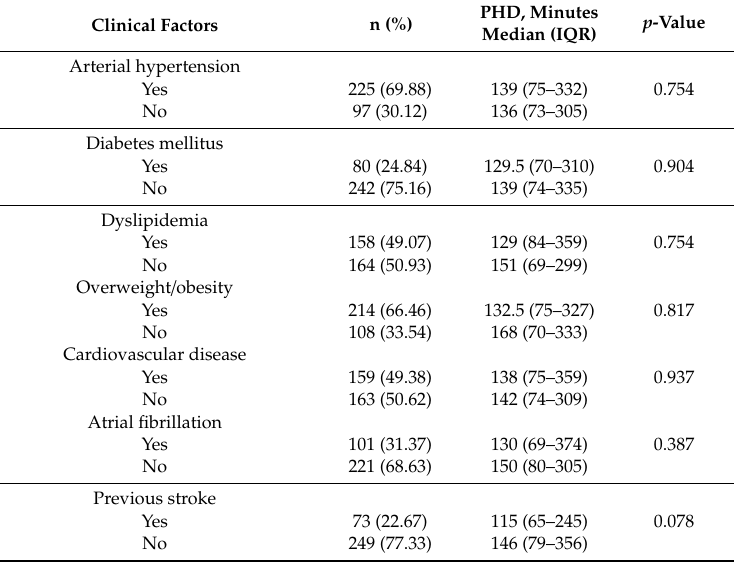
Table 2. Time from symptom onset to hospital arrival by clinical